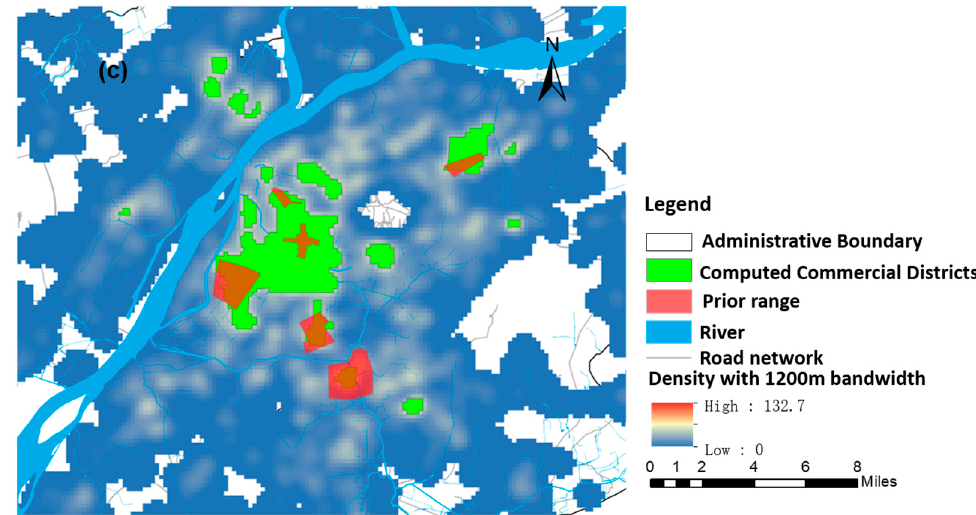
Figure 12. Commercial-intersection kernel density surface: ( a ) result with 150-m bandwidth, ( b ) result with 600-m bandwidth, and ( c ) result with 1200-m bandwidth.